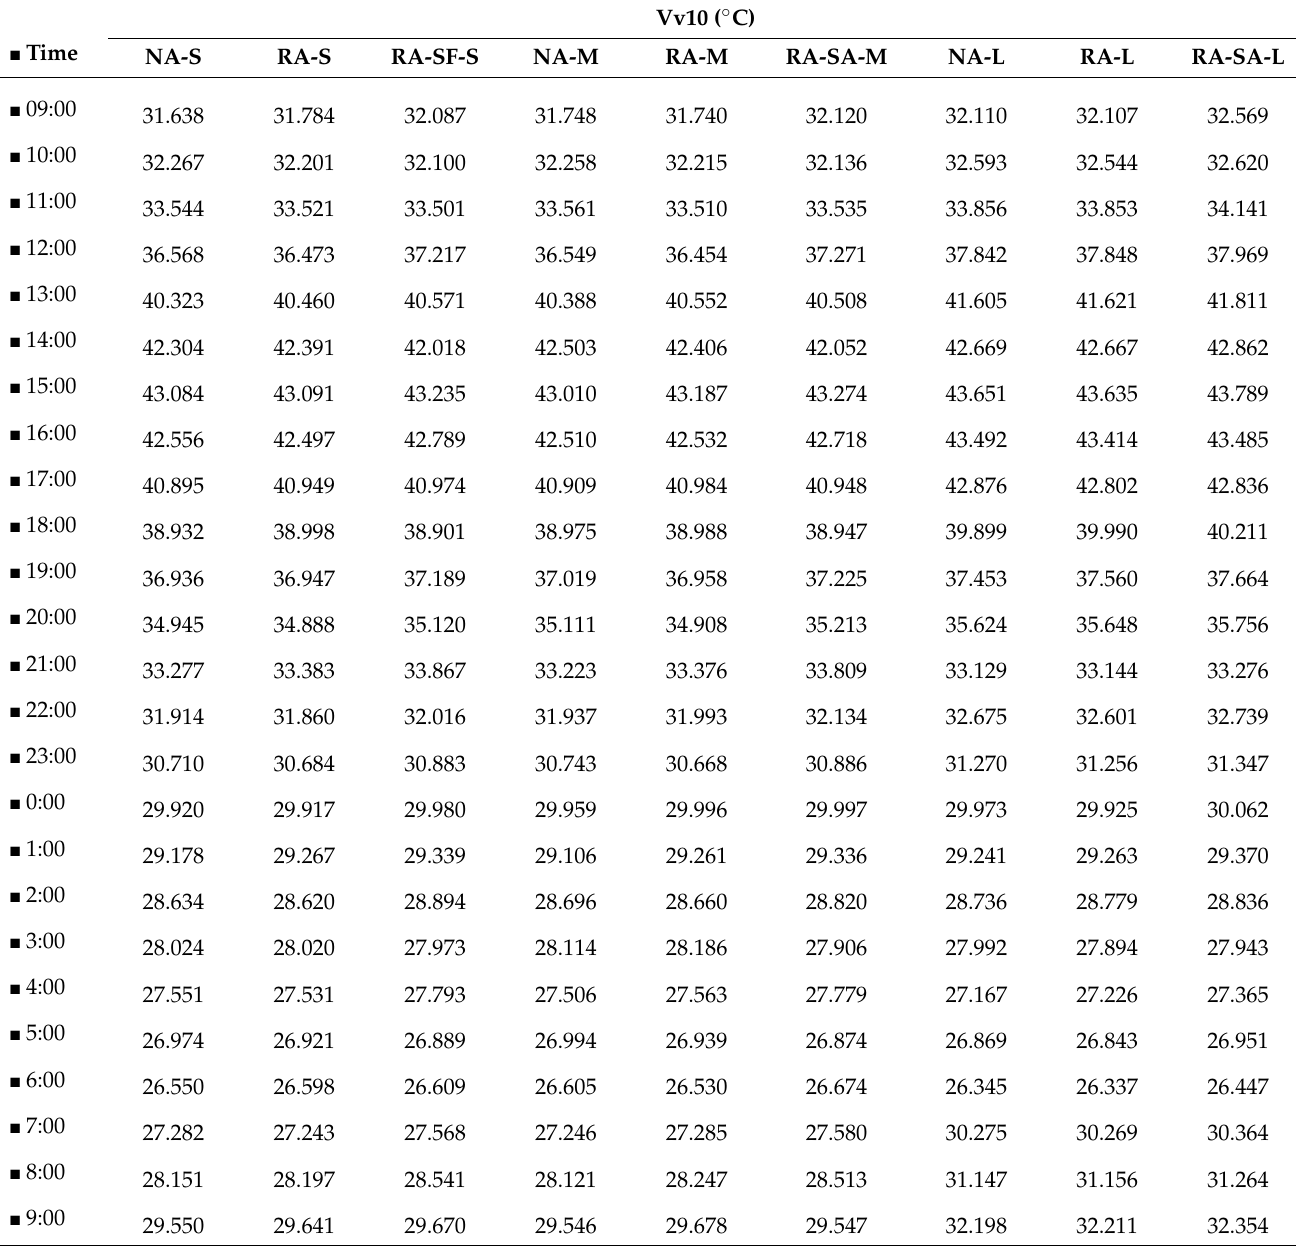
Table 7. Unit weight and water absorption characteristics of natural and recycled